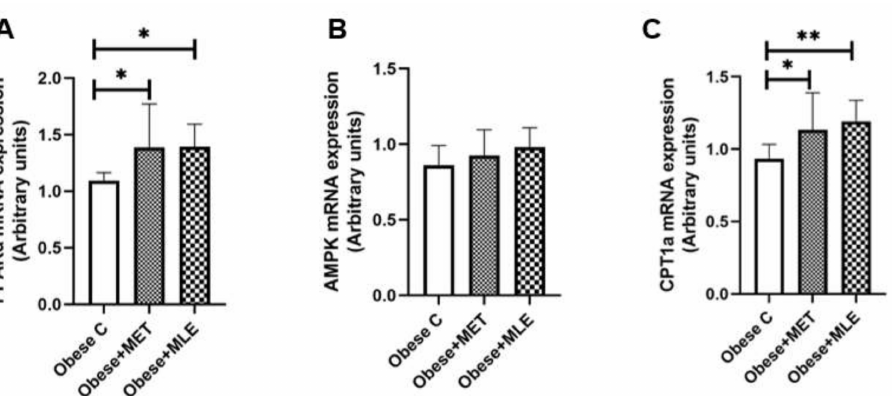
Figure 4. The effects of Marula leaf extract (MLE) on mRNA expression of β -oxidation genes, Ppar α ( A ), Ampk ( B ) and Cpt1 ( C ). Data are represented as means ± SEM, with a sample size of 5-6/group. One-way ANOVA was used to test for statistical significance at a p -value ≤ 0.05. Note: * p ≤ 0.05 vs. obese C, ** p ≤ 0.01 vs. obese C. Ppar α ; peroxisome proliferator-activated receptor alpha, Ampk; AMP-activated protein kinase, Cpt1; carnitine palmitoyltransferase